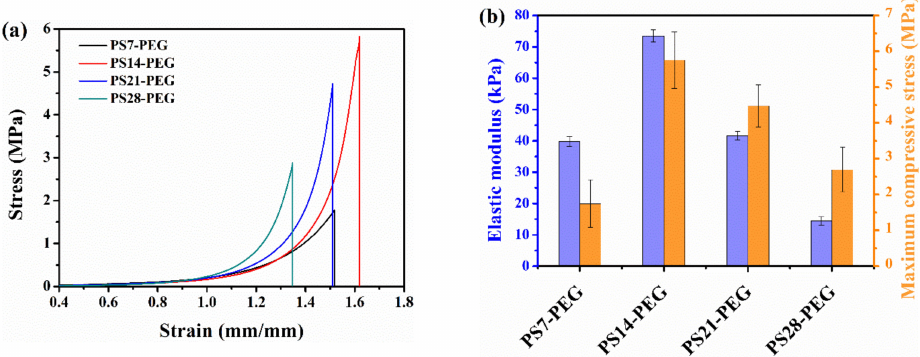
Figure 14. Mechanical properties of PS-PEG hydrogels ( a ) compressive stress–strain curves; ( b ) elastic modulus and maximum compressive